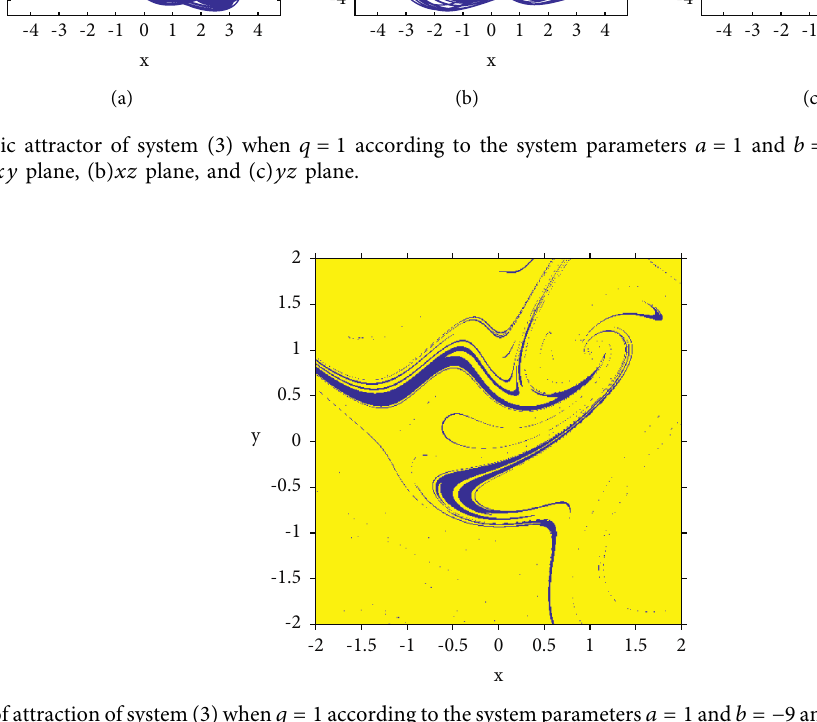
Figure 2: Basin of attraction of system (3) when q � 1 according to the system parameters a � 1 and b � − 9 and to the initial condition of the third state variable z � 0.